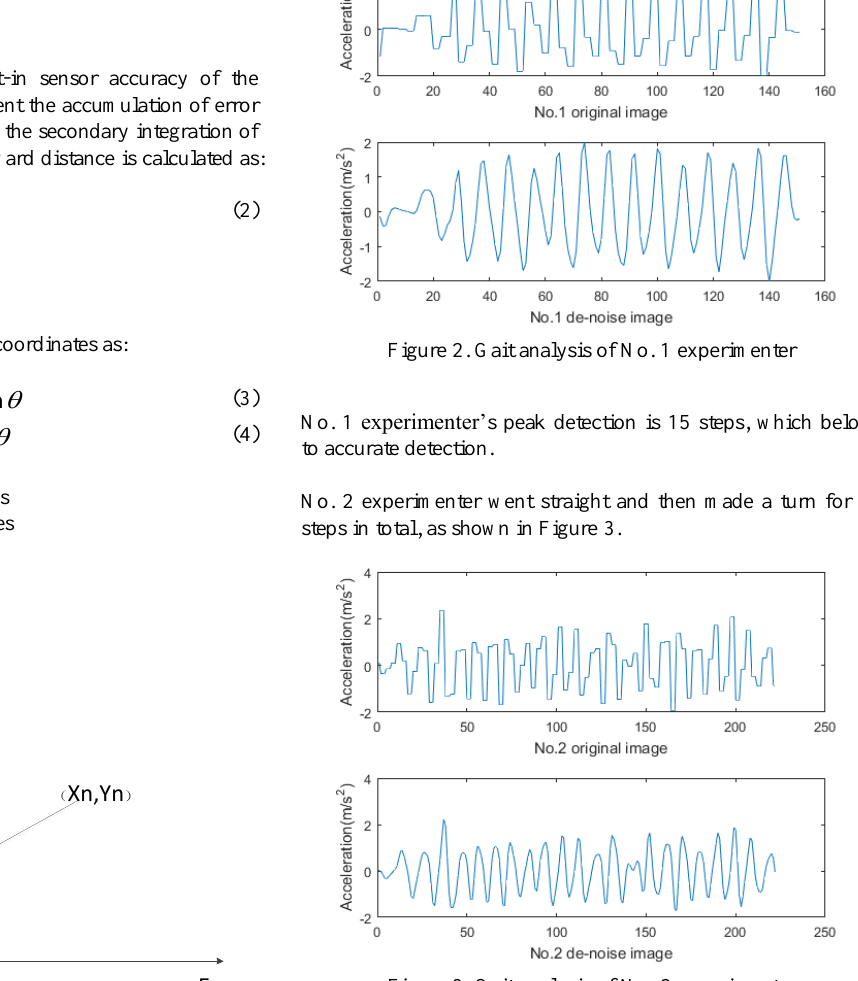
Figure 3. Gait analysis of No. 2 experimenter For No. 2 experimenter, it detects 23 peaks which means 23 steps. There is one more step than the actual it is. That is because the performer shakes at the corner which causes an added peak. No. 3 experimenter went straight 14 steps, and the detection can be shown as Figure